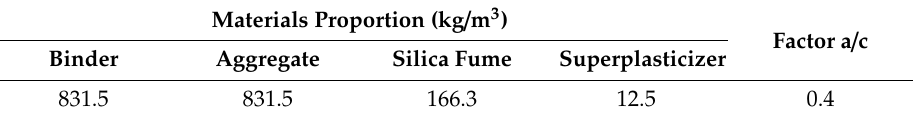
Table 2. Proportion of mortar